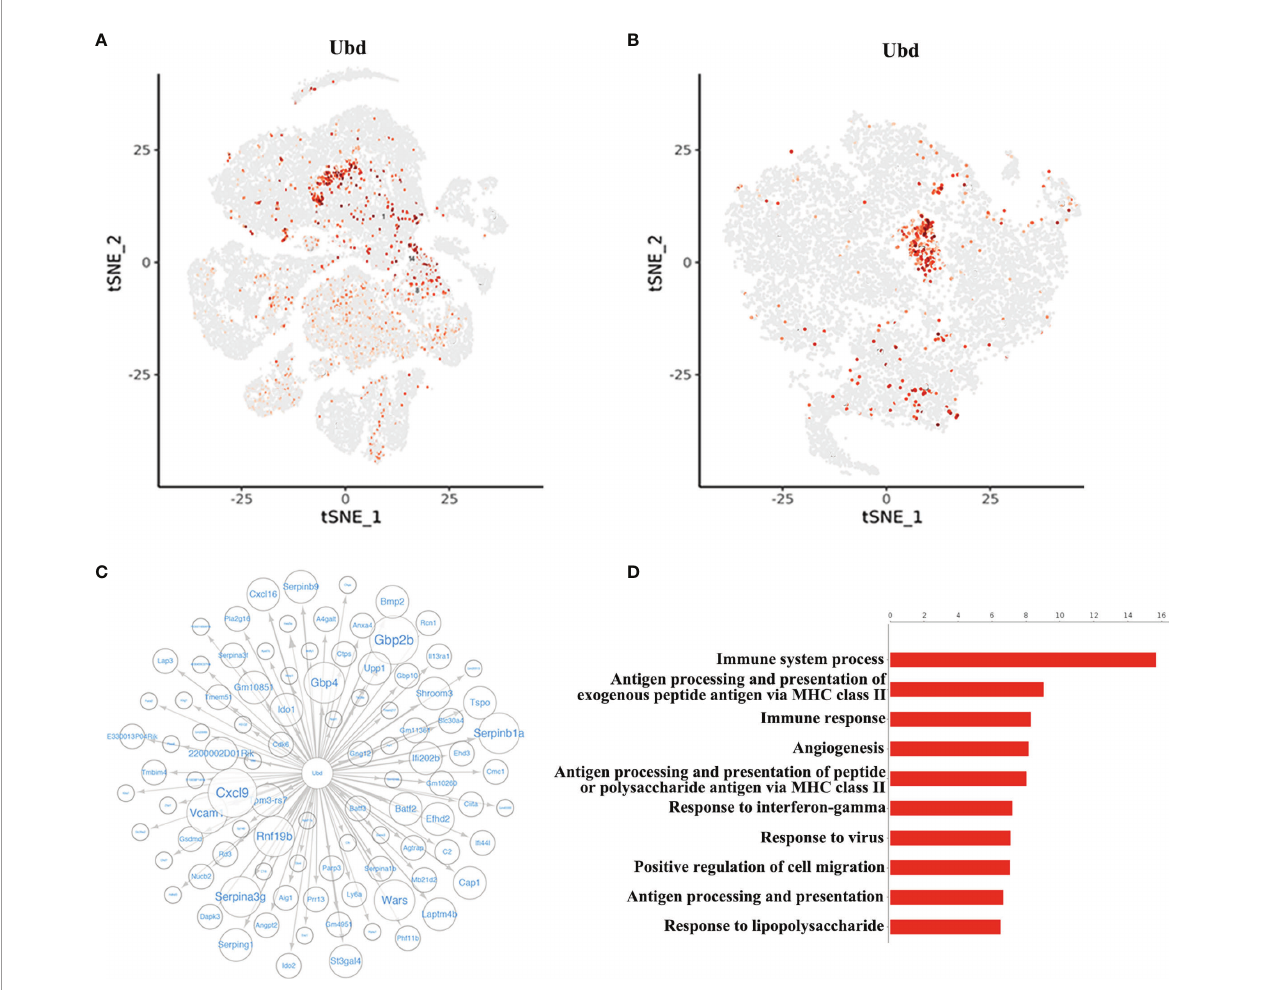
FIGURE 5 | Identi fi cation of Ubd in EC5. (A) t-SNE map (from Figure 1A ) indicating the expression of Ubd in all the cells. (B) t-SNE plot indicating the expression of Ubd in the re-clustered endothelial cells. (C) Correlation network analysis of Ubd displaying its co-expression genes in endothelial cells. (D) GO enrichment analysis with Ubd-positive ECs and Ubd-negative